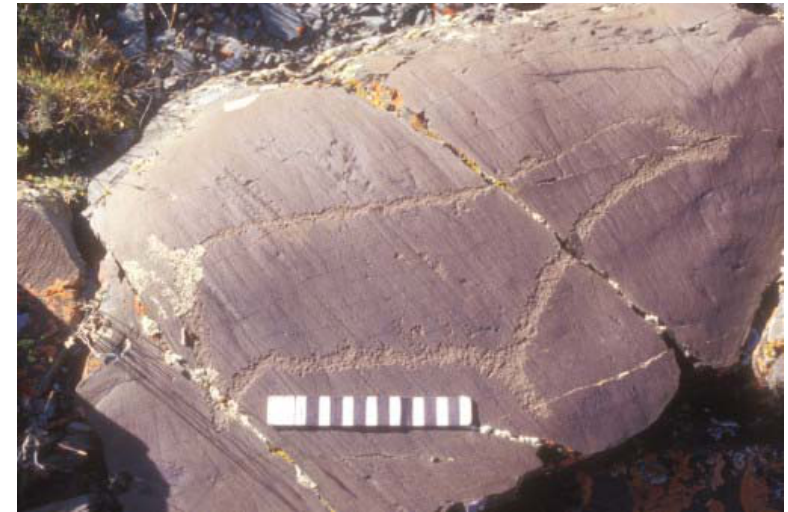
Figure 1. Unidentified animal, Tsagaan Salaa II